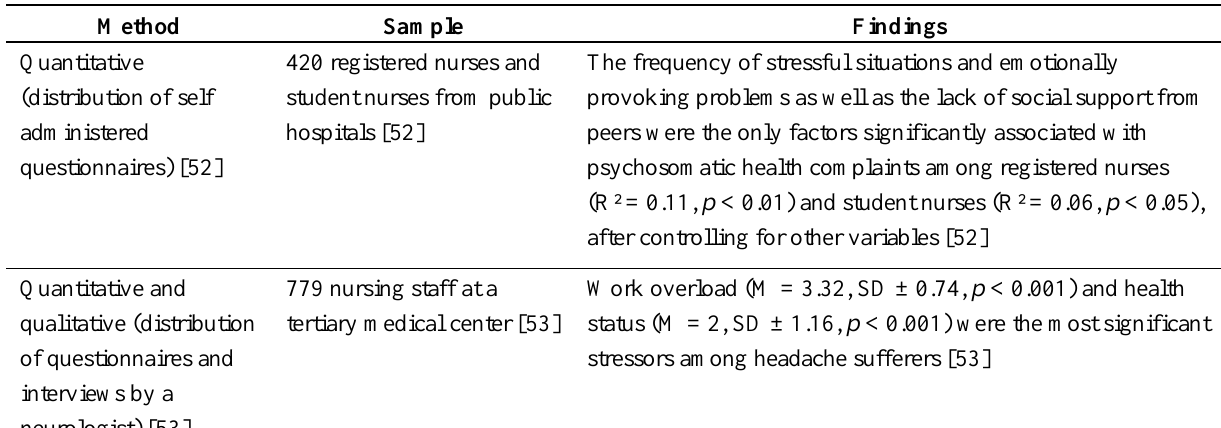
Table 3. Method, sample and findings of identified